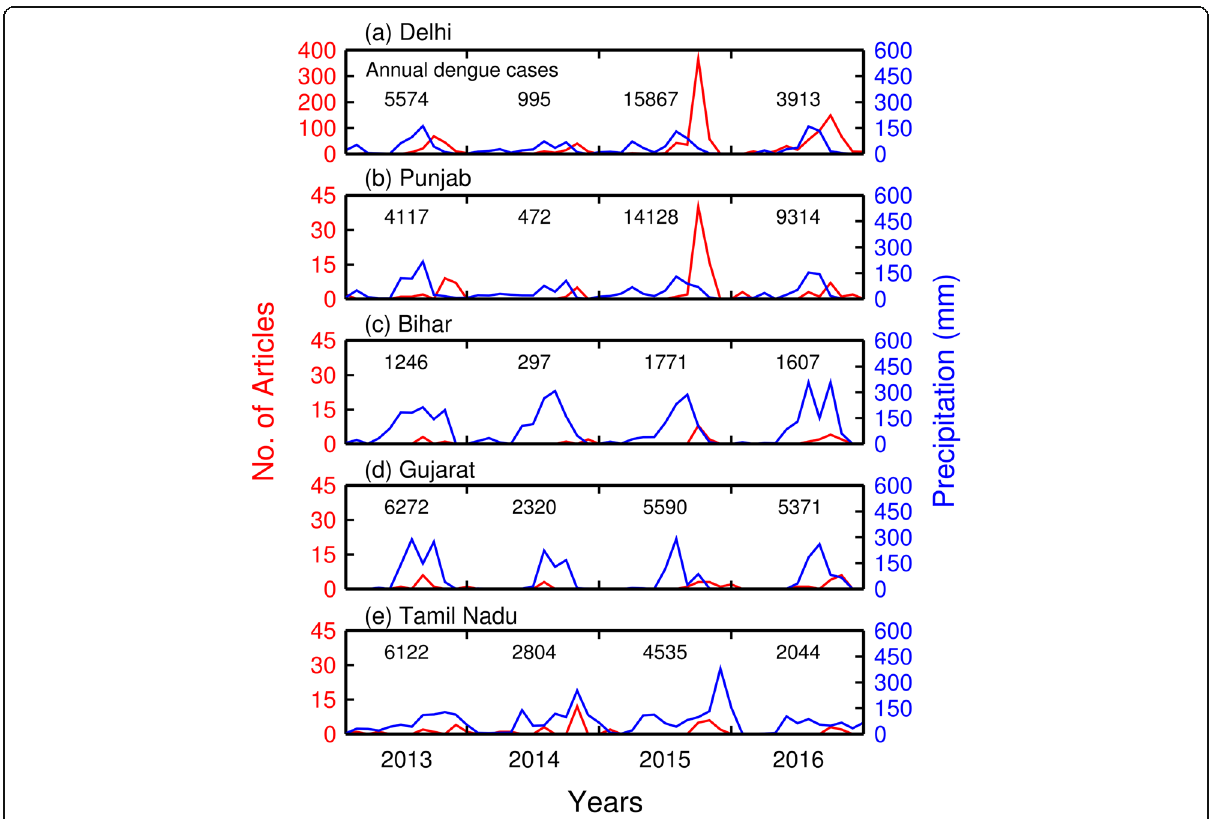
Fig. 6 The monthly number of news articles in five states compared with monthly rainfall between 2013 and 2016. For comparison, the actual numbers of disease case for each year are also